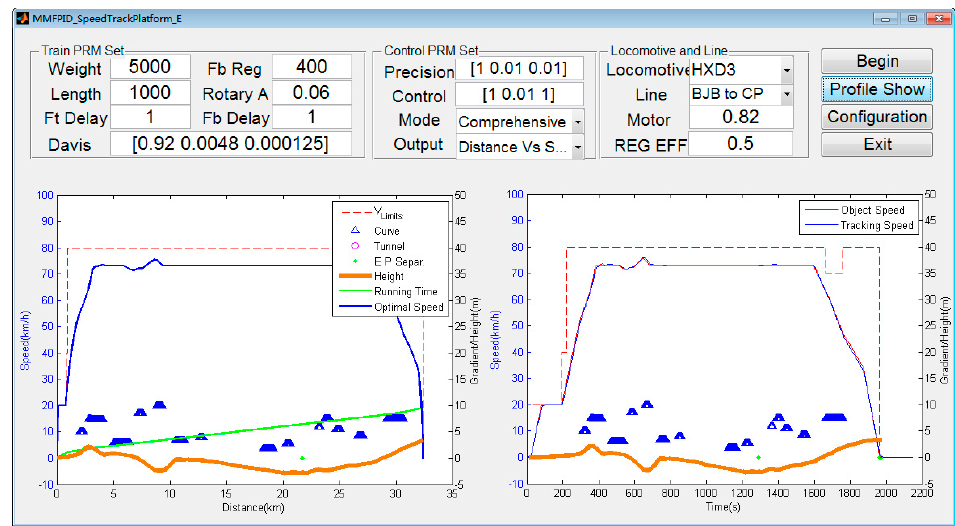
Figure 21. Framework of the simulation platform.